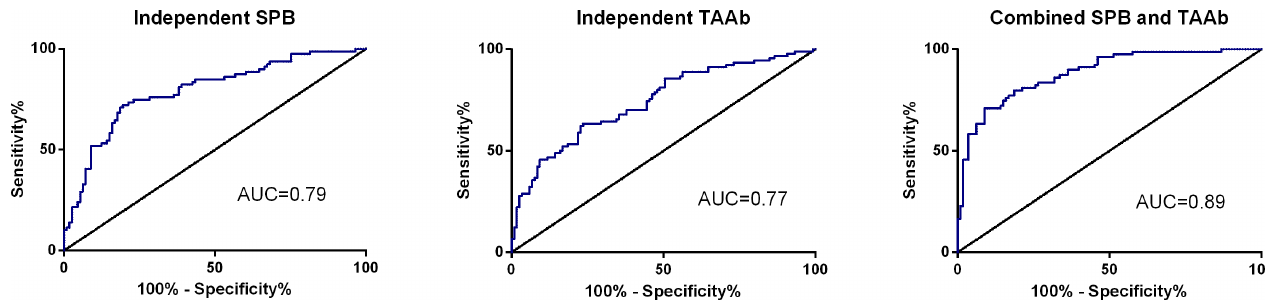
(only 3 participants in the BI-RADS 5 category were diagnosed as BBD). Overall, the data shown